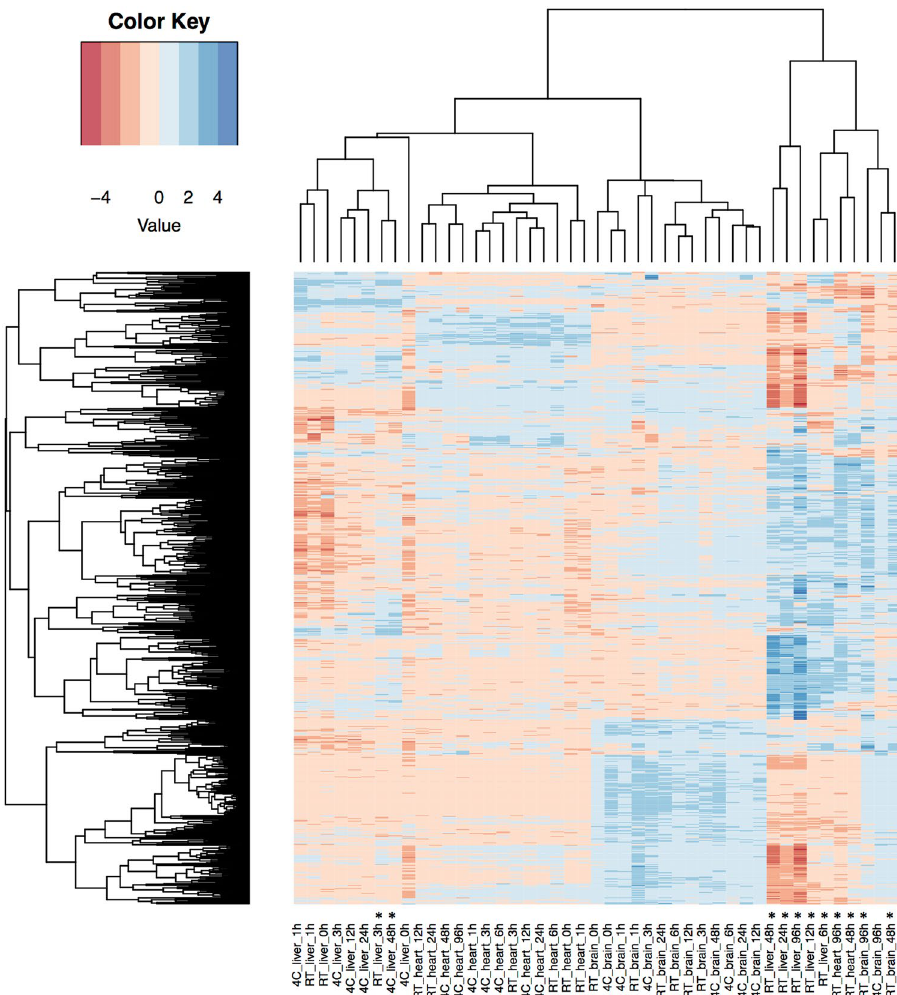
Figure 2. Influence of degradation on miRNA expression profiles as determined by microarrays. Unsupervised hierarchical clustering using Eucledian distance and complete linkage of the samples depending on expression all analysed miRNAs. Blue color indicates high, red color indicates low expression. Samples are indicated on the X axis below the heatmap with each sample referring to the storing temperature, the tissue and the storage time in hours (e.g. 4C_heart_24 h denoting the heart sample that was stored for 24 hours at 4 °C). Samples with RIN < 6 are marked with an asterisk. Clustering of the samples is shown above the heatmap. MiRNA clusters are indicated on the left-hand side of the